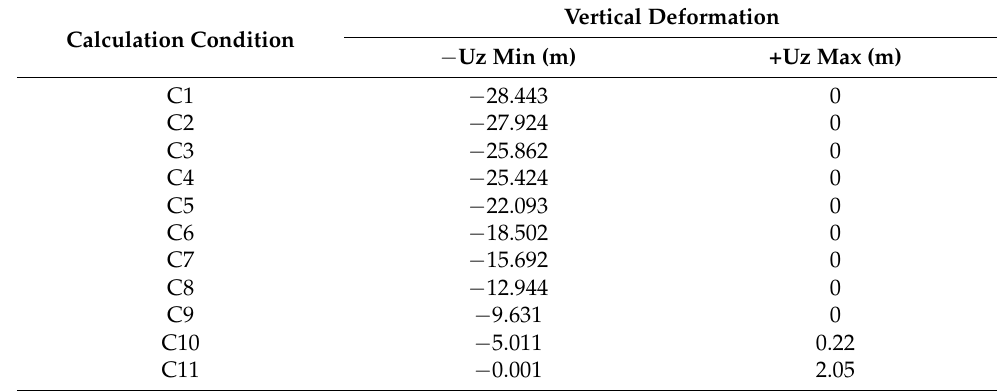
Table 12. Vertical deformation of cable